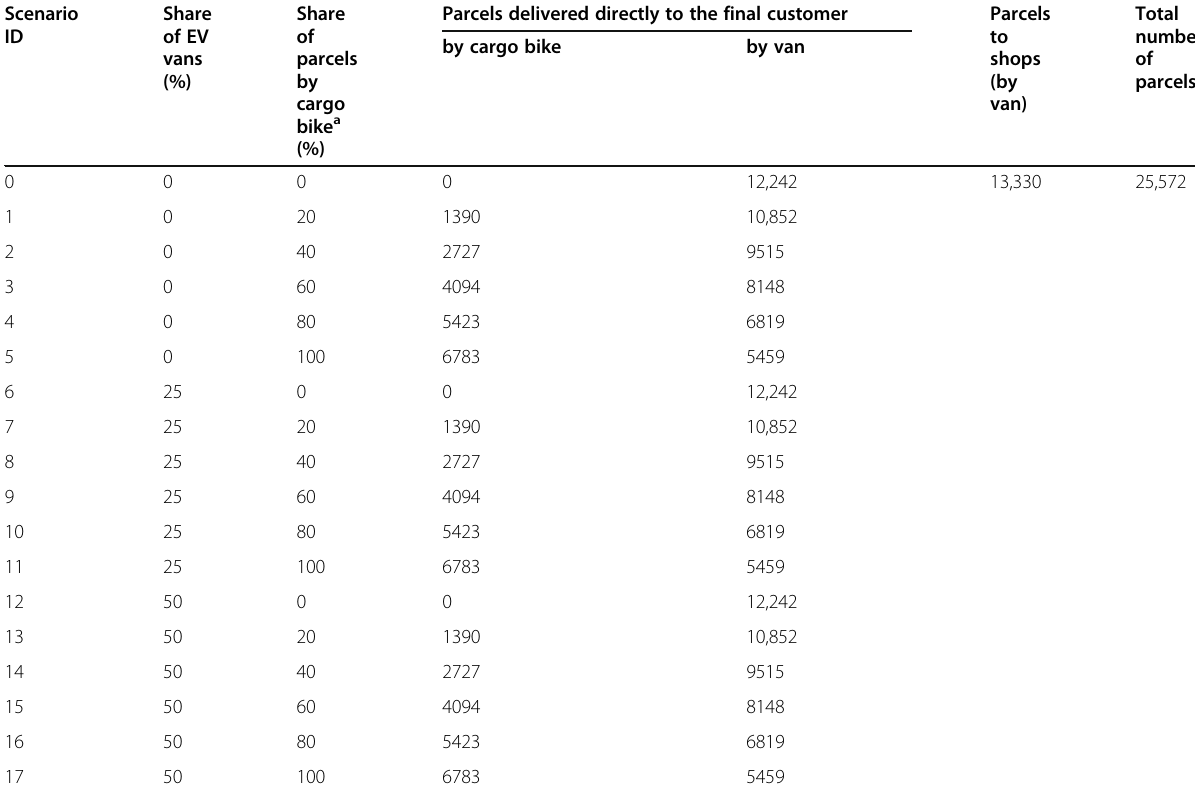
Table 1 Scenario definition with shares of cargo bikes and electric vehicle vans and daily delivered